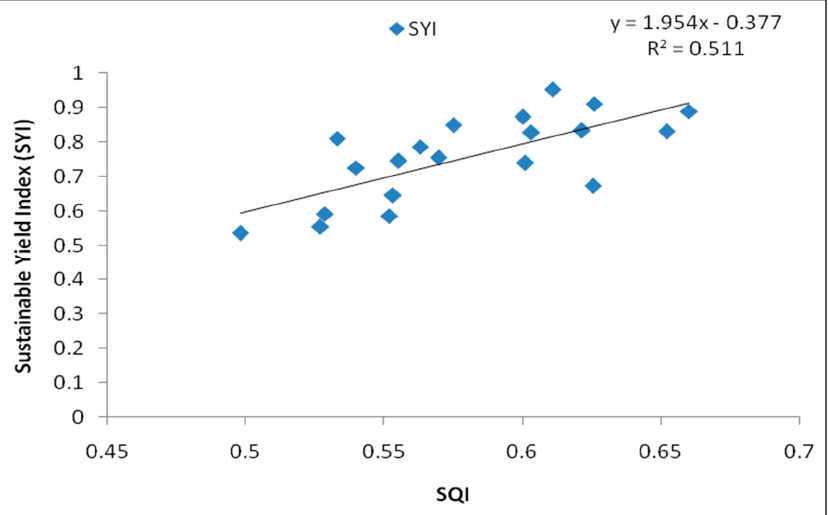
Figure 4. Relationship between sustainable yield index (SYI) and soil quality index (SQI).